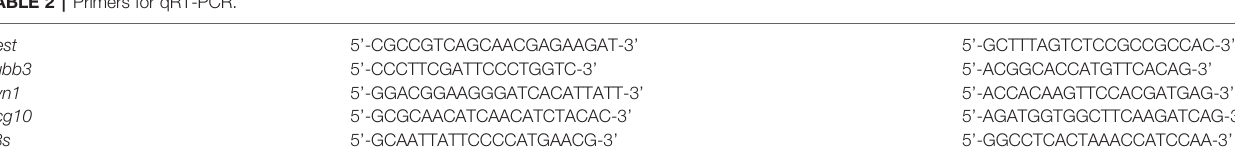
TABLE 2 | Primers for qRT-PCR.